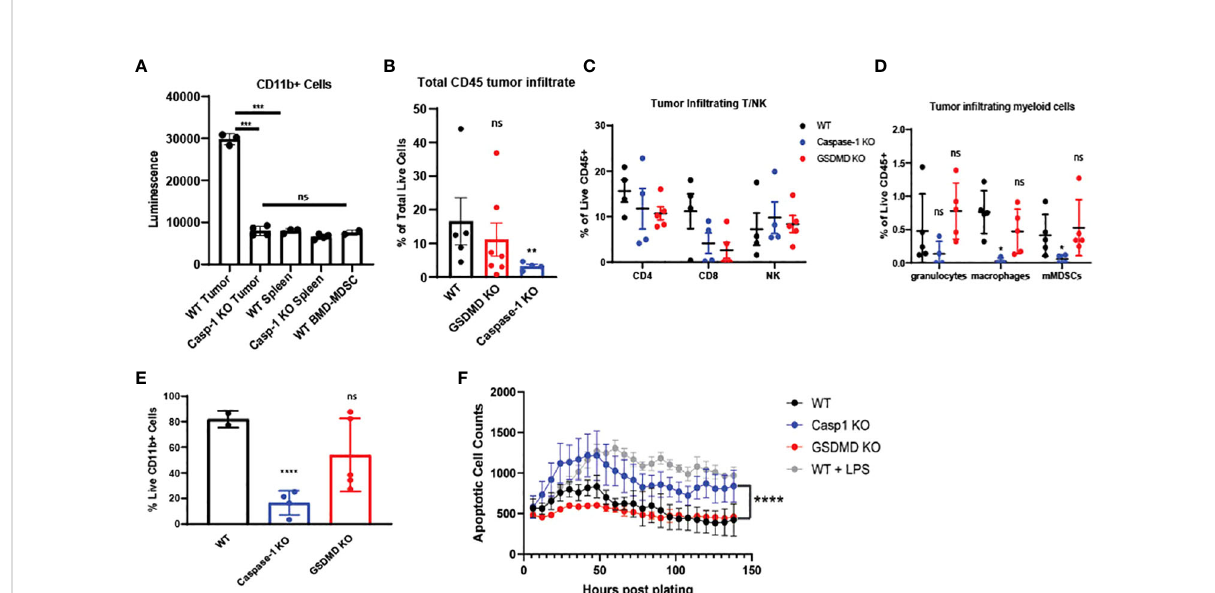
FIGURE 5 Caspase-1 deletion affects intratumoral immune landscape and myeloid cell survival in vivo (A) Caspase-1 activity is prominent in CD11b+ cells enriched from B16-mOVA tumors 2 weeks post tumor inoculation (n=3). CD11b+ cells were immediately utilized for caspase assay after sorting. Unstimulated mouse bone marrow derived myeloid suppressor cells were utilized as a negative control. (B) Caspase-1 deletion reduces global CD45+ cells in the TME compared to WT as noted by fl ow cytometry (n=5 mice/group, GSDMD= gasdermin D KO). B16-mOVA tumors were harvested from WT or caspase-1/GSDMD global KO mice 2 weeks post tumor inoculation. Data is fi rst gated on the CD11b+ population then shown as the total live CD45+ cells in the total tumor. (C) Flow cytometry identi fi cation of tumor in fi ltrating T and NK cells. B16 mOVA tumors were harvested from WT or caspase-1/GSDMD null mice 2 weeks post tumor inoculation (n=5 mice/group). (D) Caspase-1 reduces the percentage of macrophages and monocytic MDSCs in the tumor compared to WT as noted by fl ow cytometry of B16-mOVA tumors (n=5 mice/group). Myeloid cell subtypes were identi fi ed according to the gating strategy outlined in Supplemental Figure 3. (E) Caspase-1 reduces the percentage of total live CD11b+ cells in the TME as noted by fl ow cytometry of B16-mOVA tumors. Data shown as a percentage of the